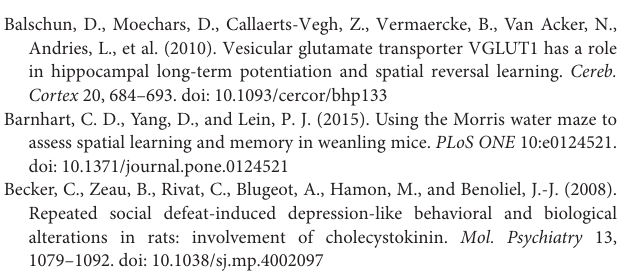
Hippocampal CA1, CA2, CA3 region, and Dentate Gyrus, and in Cortex. The left panel depicts antisense probe and right panel depicts sense probe. Scale 1 mm. (B) Antisense Wdr13 probing (top) of a sagittal section of mouse brain showing significant hybridization in Cerebellum, Hippocampus, and Cortex. Scale 1 mm. (C) A coronal section of cortex hybridized with anti-sense Wdr13 probe. Scale 200 µ m. Supplementary Figure 2 | Histological staining of brain sections from Wdr13 − / 0 and wild-type mice showed no significant differences ( n = 3). (A) Nissl staining of a coronal section of brain showing the hippocampus. Wild-type is shown on left and Wdr13 − / 0 on right. (B) Nissl staining of sagittal section of brain. Wild-type is shown in top and Wdr13 − / 0 in bottom panel. (C) H&E staining of a coronal section of brain. Wild-type on left and Wdr13 − / 0 on right. (D) H&E staining of sagittal section of brain. Wild-type on top and Wdr13 − / 0 bottom panel. Scale 1 mm. Supplementary Figure 3 | Additional dataset: Behavioral analysis of Wdr13 − / 0 and wild-type mice in CD1 background (Cohort 1). (A) Open field test. Wdr13 − / 0 mice showed marginally ( T -test; p = 0.07) decreased exploration time in the central area of the open field as compared to the wild-types. (B) Novel object recognition test. Wdr13 − / 0 mice showed a trend ( T -test; p = 0.06) of decreased exploration of novel object than the familiar object ( n = 5). (C) Elevated plus maze test. There were no significant differences ( T -test; p > 0.05) between Wdr13 − / 0 and wild-type mice in total time spent in closed or open arms ( n = 5). (D) Morris water maze test. Wdr13 − / 0 mice spent significantly more time [ANOVA, F (1 , 56) = 5.44; p < 0.05] in the target quadrant during extinction trials as compared to the wild-type mice ( n = 5). Data represented as ± SEM. Wt, wild-type; Wdr13 − / 0 , Wdr13 knockout mice. ∗ p < 0.05. Supplementary Figure 4 | Tracking adult neuronal proliferation in Wdr13 − / 0 and wild-type mice using BrDU labeling. (A) Representative images of fluorescent labeling for anti-BrDU in wild-type and Wdr13 − / 0 Dentate Gyrus (DG). (A ′ ) There was no significant difference ( T -test; p > 0.05) in the number of BrDU labeled cells from the DG of hippocampus. (B) Representative images of Dab staining for anti-BrDU labeling in wild-type and Wdr13 − / 0 Sub Ventricular Zone (SVZ). (B ′ ) There was no significant difference ( T -test; p > 0.05) in the number of BrDU labeled cells from SVZ of Wdr13 − / 0 and wild-type mice. (C) There were no significant differences in number of BrDU positive cells in hippocampal DG and in (D) . SVZ of Wdr13 − / 0 mice as compared to the wild-type mice after performing learning task in Morris water maze. Data represented as ± SEM. Wt, wild-type; Wdr13 − / 0 , Wdr13 knockout mice. Supplementary Figure 5 | Real time analysis of hippocampus from Wdr13 − / 0 and wild-type mice which were exposed to a novel environment revealed increased transcripts of c-Fos and Arc in Wdr13 − / 0 hippocampus. However, there was no significant difference ( T -test; p > 0.05) in transcript levels of Bdnf ( n = 4). Data is represented ± SD. Wt, wild-type; Wdr13 − / 0 , Wdr13 knockout mice. Supplementary Figure 6 | Western analysis. (A) Representative blot of WDR13 overexpression and knockdown (from left) in Neuro2a cells. (B) Relative quantification of WDR13 overexpression (Mann Whitney; p < 0.05) and knockdown (Mann Whitney; p < 0.05). (C) Percent relative expression (compared to controls) for WDR13 knockdown and overexpression. (D) Representative blot and (E) relative quantification (triplicates) of c-JUN overexpression (Mann Whitney; p < 0.05) in Neuro2a cell line. Data is represented ±